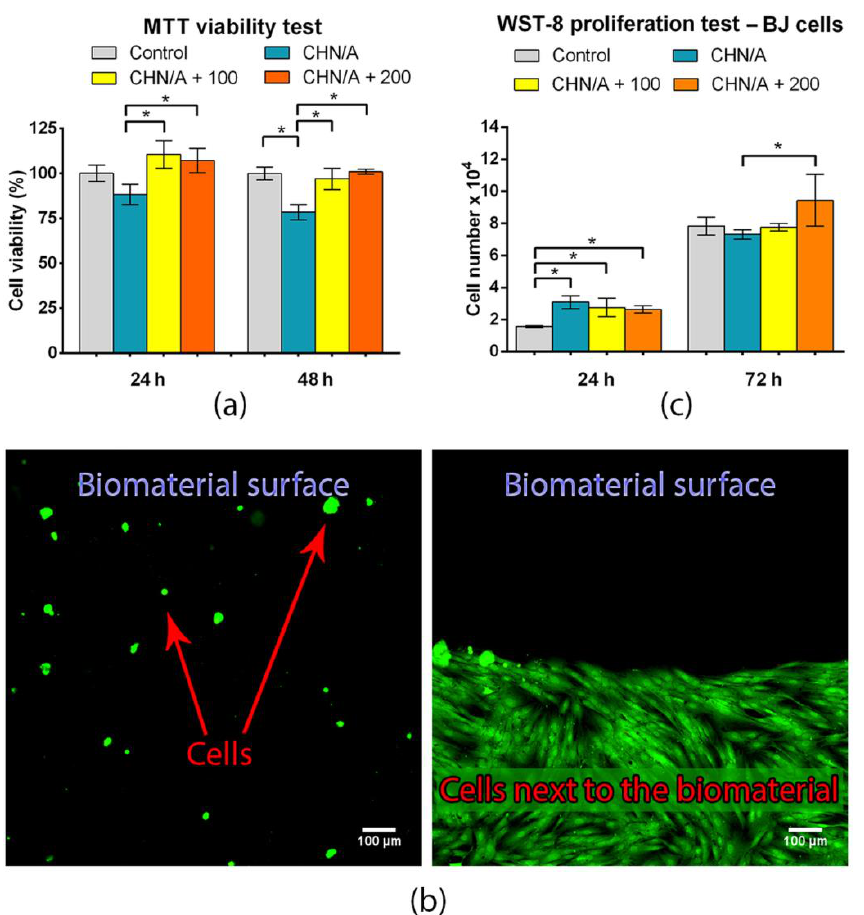
Figure 8. Basic biocompatibility tests for the chitosan/agarose biomaterial: ( a ) MTT cytotoxicity test conducted according to ISO 10993-5 [20] using extracts of the biomaterials and human skin fibroblasts (BJ cell line) (* statistically significant results between indicated groups, p value < 0.05, one-way ANOVA followed by Tukey’s test); ( b ) Live/Dead staining of the human skin fibroblasts cultured for 2 days on the CHN/A biomaterial and polystyrene surface next to the dressing (green fluorescent represents viable cells while red fluorescent represents dead fibroblasts); ( c ) Fibroblast proliferation determined in a two-compartment environment using cell culture inserts by colorimetric WST-8 assay (* statistically significant results between indicated groups, p value < 0.05, one-way ANOVA followed by Tukey’s test).